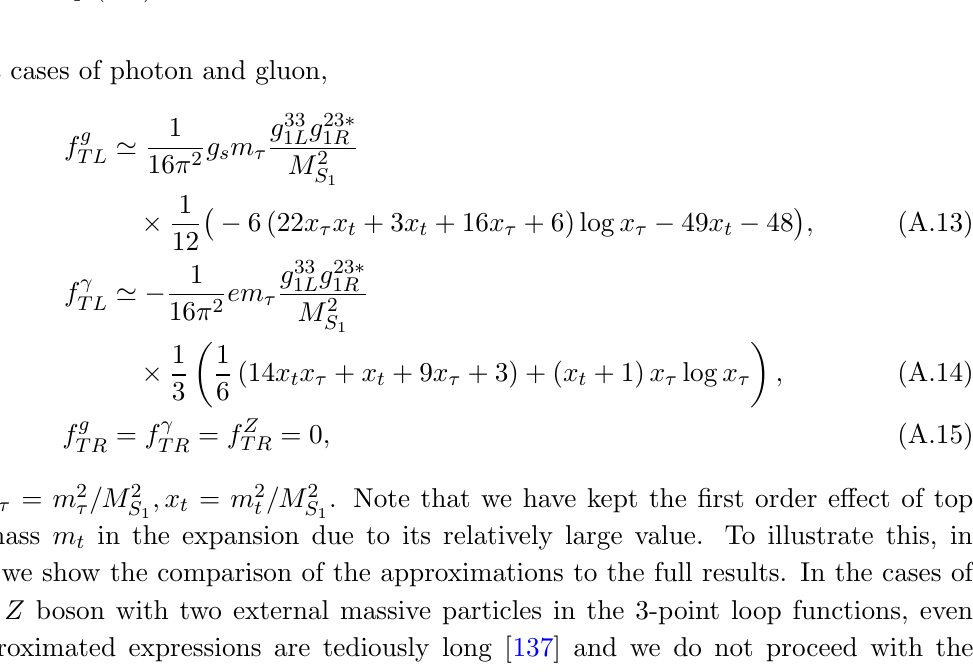
Figure 6 . The comparison of the approximations in eq. (3.10) and eq. (3.11) to the full results in eq. (A.1) and eq.